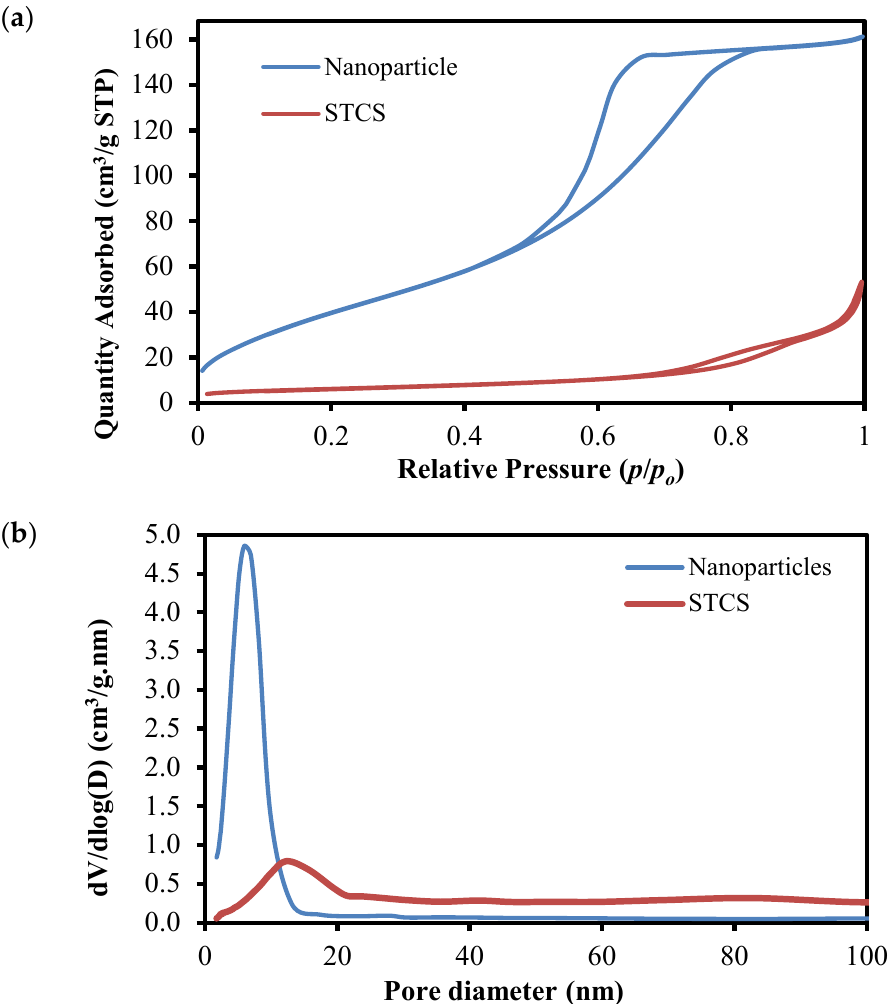
Figure 5. ( a ) Absorption-desorption isotherm of the synthesized TiO 2 nanoparticles and STCS structures and ( b ) pore-size distribution of the synthesized TiO 2 nanoparticles and STCS structures. The morphology of the printed photoelectrode films was analyzed using FESEM.